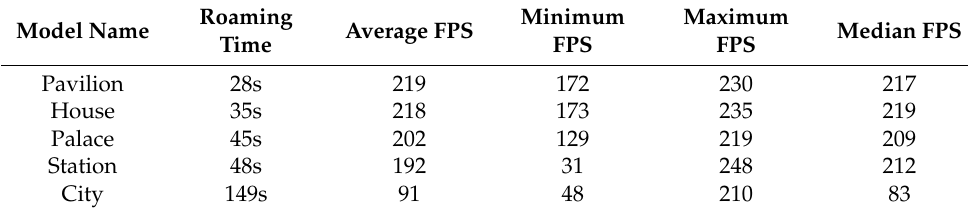
Table 3. Refinement delay time statistics.